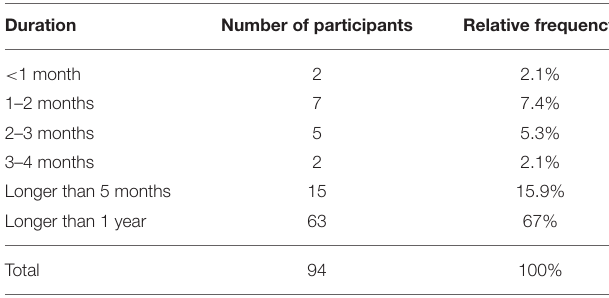
TABLE 3 | Adherence to the chosen LC diet among study